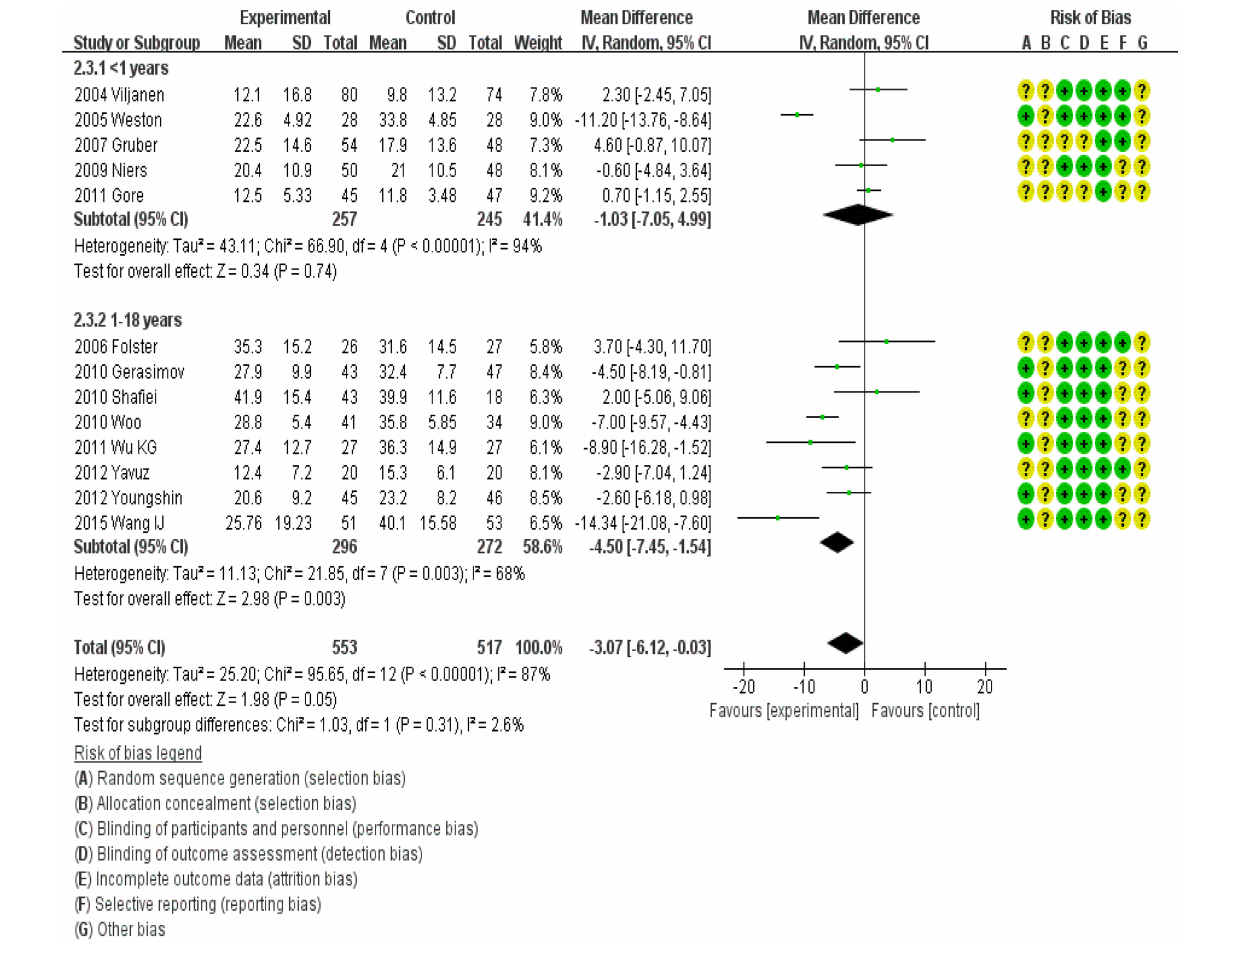
FIGURE 4 | MD scoring with probiotics treatment compared to control and placebo interventions by age